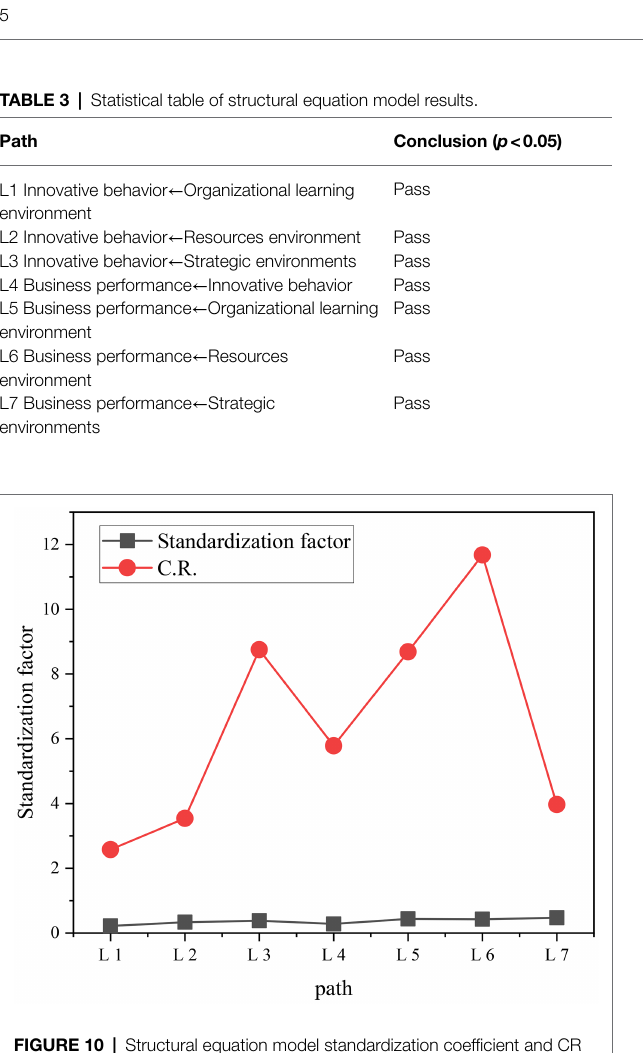
FIGURE 10 | Structural equation model standardization coefficient and CR distribution diagram. CR, construct reliability.